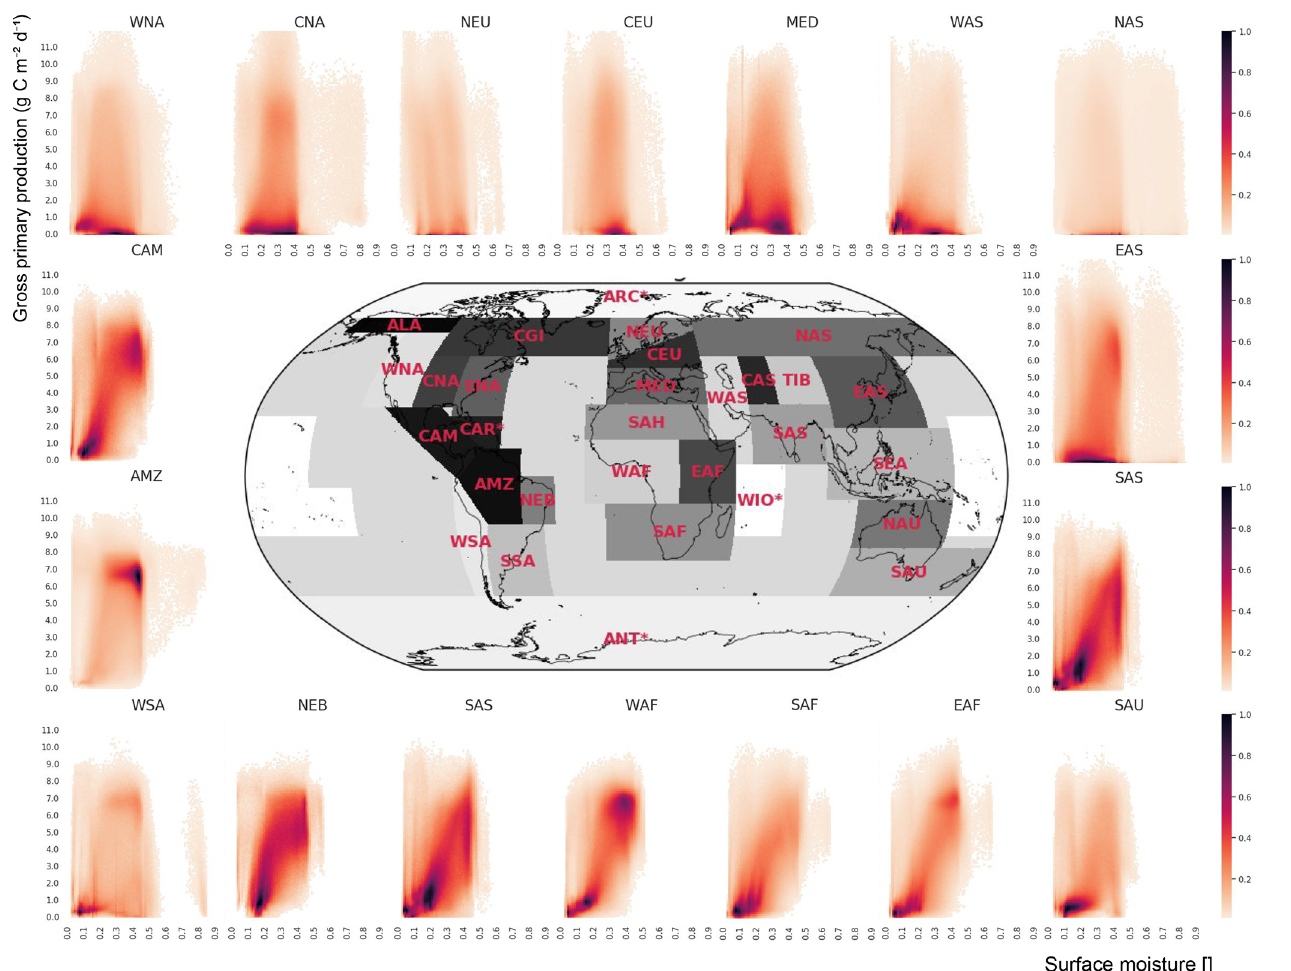
Figure 8. Bivariate histograms summarizing the joint distribution of surface moisture and gross primary production. The estimates are computed over the entire time series for the different Intergovernmental Panel on Climate Change (IPCC) regions. The density is square root transformed to emphasize areas of higher density. In arid regions (e.g. CAM, NEB, WAF, SAFM, EAF), the tight relation between surface water and primary production is